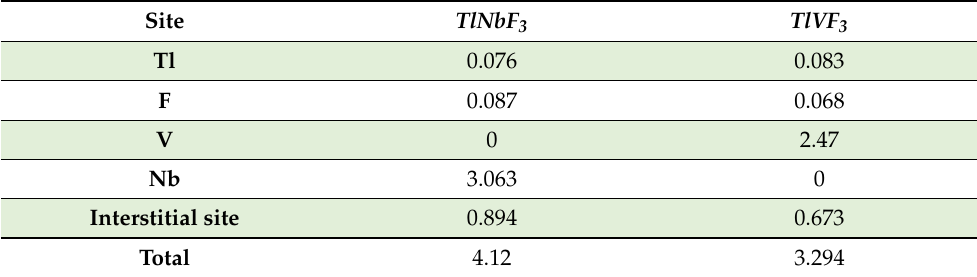
Figure 4. TDOS and PDOS of TlVF 3 and TlNbF 3 in both (spin-up plus spin-down) alignments. Table 3. Investigated magnetic moments for TlNbF 3 and TlVF 3